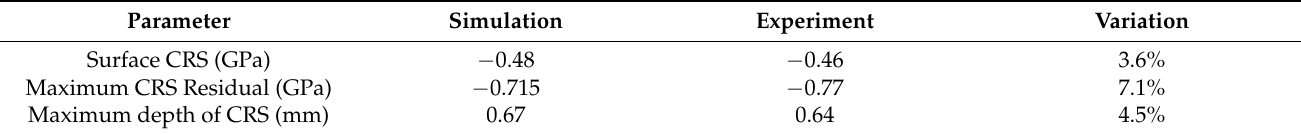
Table 5. Summary of the comparison of the simulated and experimental